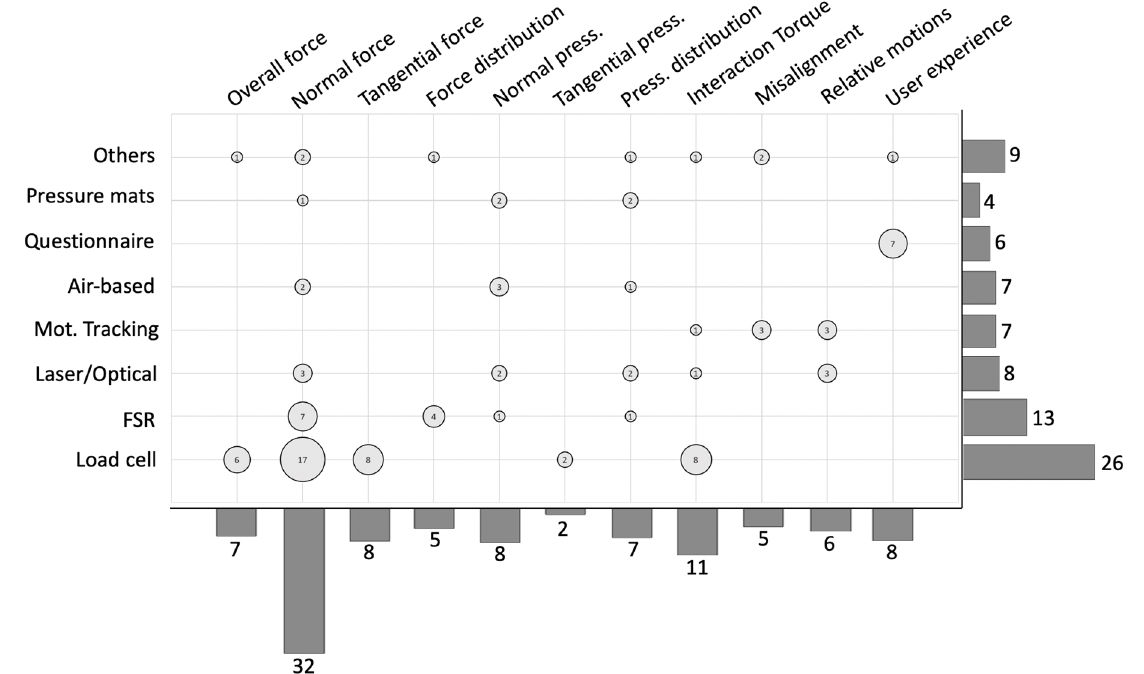
Figure 4. . Figure 4. Metrics and sensors solutions in the results. Bar plot on the right represents the number of publications including the listed sensor solutions. Bar plot on the bottom represents the number of publications including the listed metrics. Circles represent the number of studies extracting the relative metric through the relative sensor solution at the